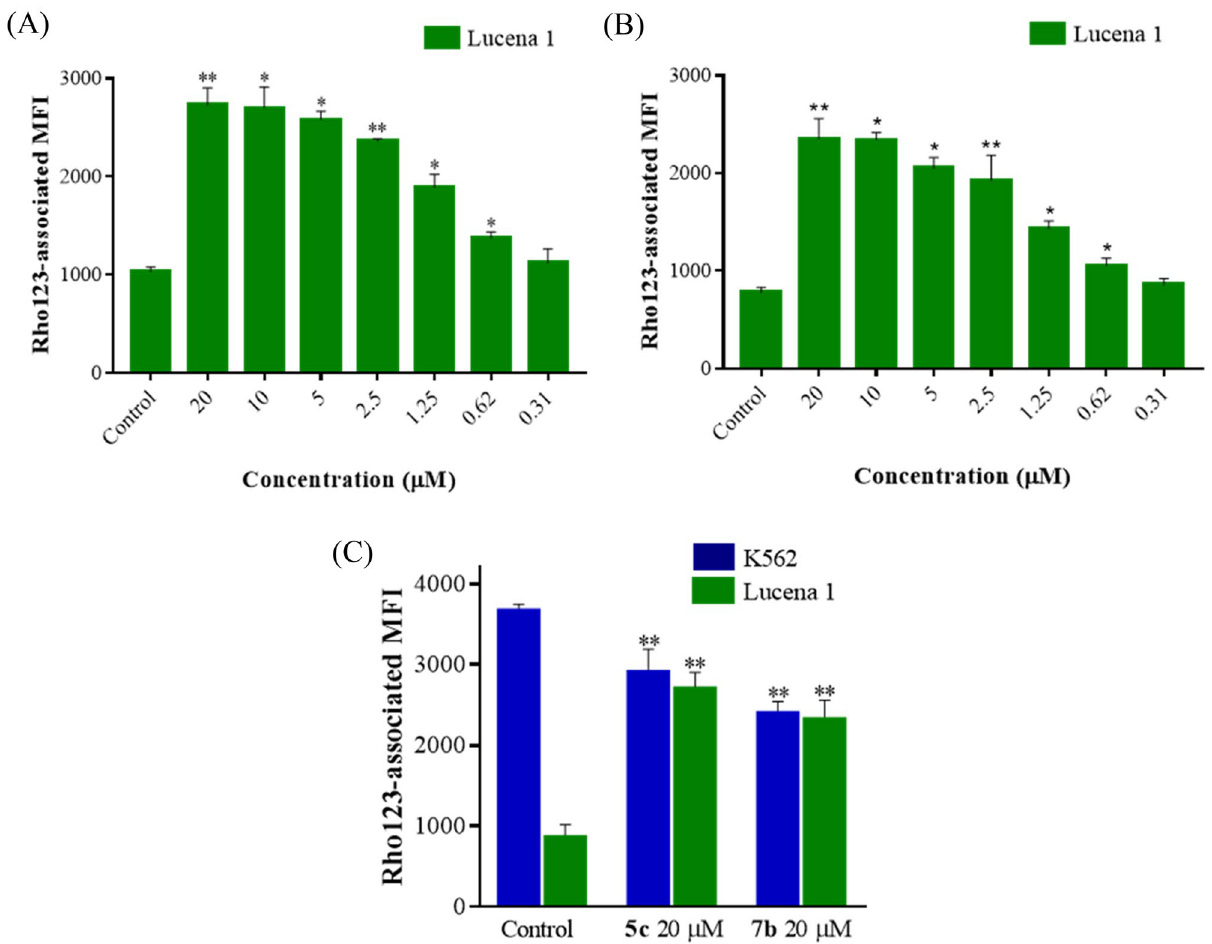
Figure 3. Inhibition on P-gp rhodamine 123 (Rho123) outward transport by different concentrations of compounds 5c ( A ) and 7b ( B ) determined by accumulation assay in Lucena 1 and ( C ) at 20 μM of both compounds in Lucena 1 and K562 cells. Rhodamine 123 associated intracellular fluorescence significantly increased in Lucena 1 by treatments with selected compounds but not in K562. Significant differences relative to the respective negative control were determined by using a paired one-tailed Student’s t test (** p < 0.01, * p < panel of assayed compounds, even for those having similar structures but sharp differences in Dox accumulation profiles. Most of the mild and all the powerful inhibitors fell inside the site also shared by Dox and Taxol (Fig. 5), involving strong interactions with the aromatic residues, mainly from TMH 4, 5 and 6 from one homologous half and with those from TMH 7 and 12 from the other half of the transporter. Figure 6A shows a superimposition of the most stable docked poses of active compounds 4b , 5b–c , 6a–b , 7a–c , 10 and 11 along with the top reference inhibitor, tariquidar and Dox. A gross common feature for all these poses in this binding pocket is that they all fold into a distorted “U”-shape. The aromatic edges of each compound accommodated as the branches of the “U” with an aliphatic/conjugated flexible bridge as its camber. This flexible intermediate portion, which also itself interacts with TMH 12, allowed for the turn or camber. In contrast, the compounds depicted in Fig. 6B are those that were too short or too long and not flexible enough to accommodate as the more powerful compounds did at the site of Fig. 6A. None of them were active. These molecules can either fit into just one of the branches of the “U”, as observed with compounds 5, 8a or 9a , or fall into a different pocket where there is no interaction with residues from TMH 6 and 12, as observed with compounds 2 , 2b , 2c , 3a – c, 8 or 9 . The relevance of such structural determinants may be clearly illustrated by comparing the inactive compound 3c with one of the strongest inhibitors, compound 5c , both with very similar chemical structures, including the ortho -dimethoxy substitution in the quinolinone ring. The only dif- ference between both entities is that the flexible linker to the quinolinone, the group —NHCH 2 —, is replaced by a longer and less flexible carbonyl-vinyl (—C(O)—CH ═ CH—) (Fig. 1). In addition to the two main groups of compounds shown in Fig. 6A,B, compound 3 with moderate activity (MEC = 10 µM, Table 1) was found to fit partially into the pattern of Fig. 6A, also touching TMH 11, a contact that is not shared by any of the other ligands (Supplementary Fig. S3, online).